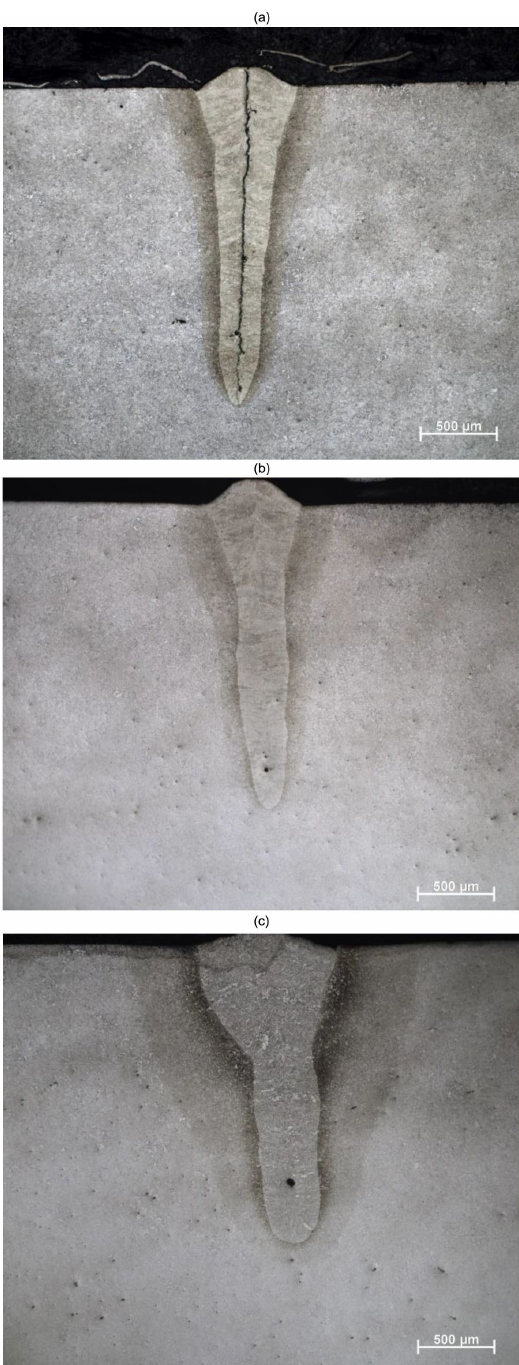
Figure 4. Optical macrographs of the welds: (a) RT; (b) PWHT and (c)